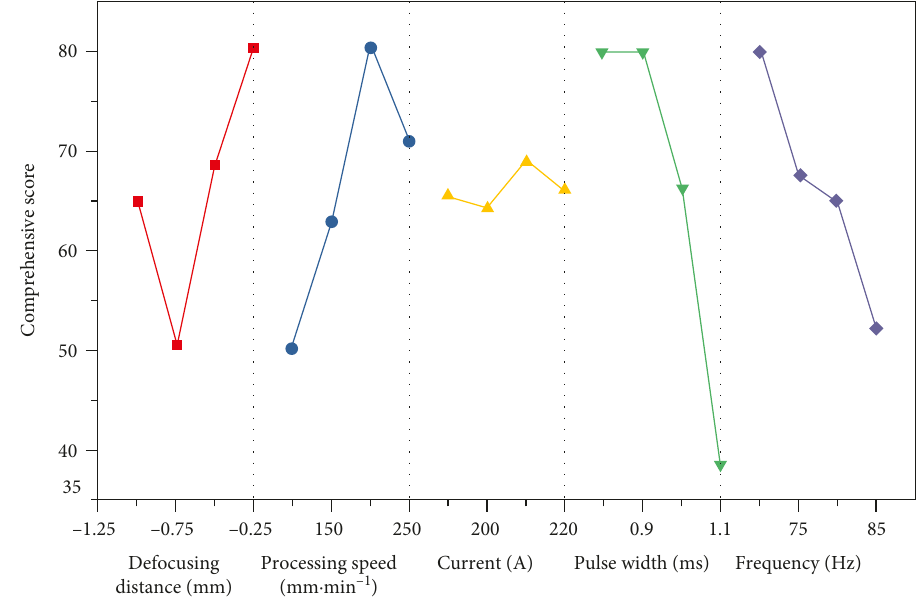
Figure 3: The e ff ect curve of horizontal degree. Table 5: Variance analysis